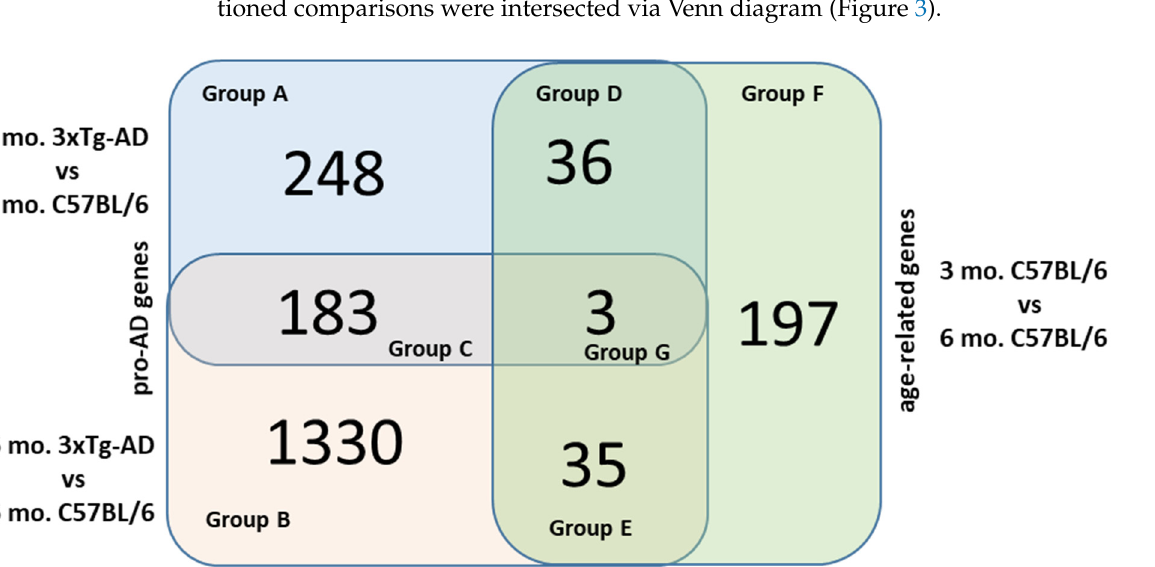
Figure 3. Venn diagram of the three comparisons performed among sham mice.